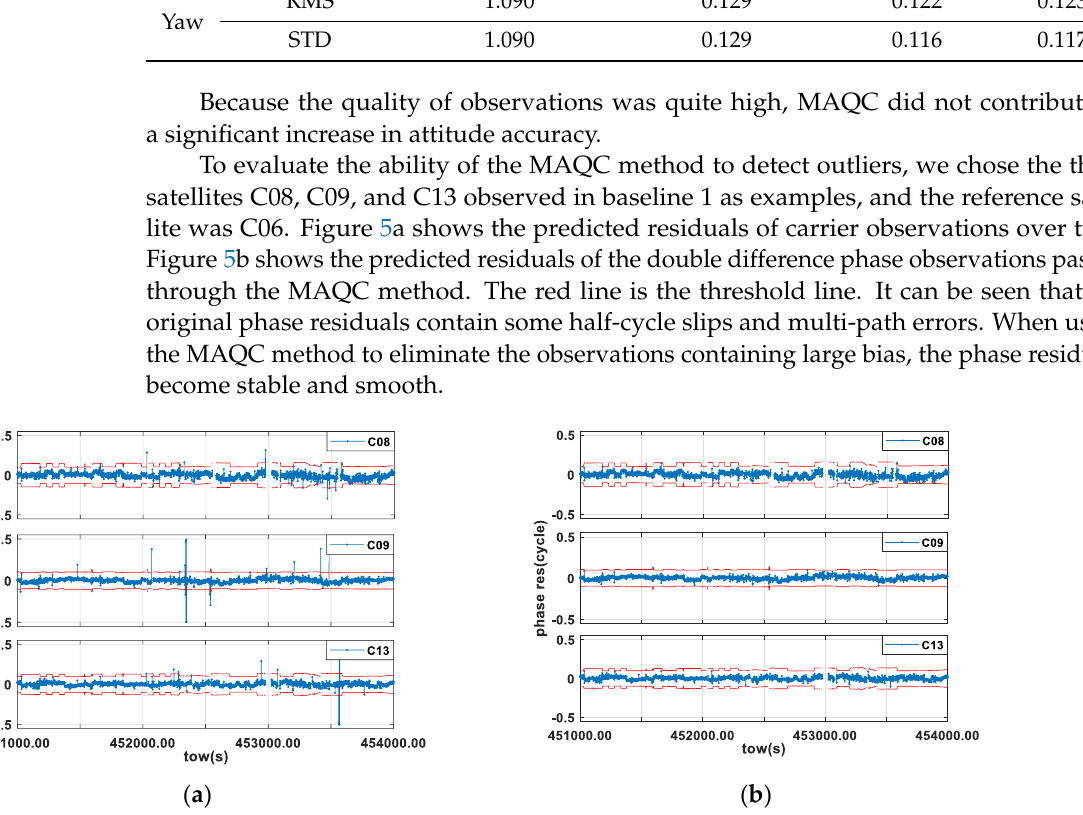
( b ) Figure 6. Residuals of carrier phase in simulated experiment: ( a ) prediction residuals of carrier phase; ( b ) residuals of the retained carrier phase measurements by MAQC method. The rea lines symbolize the threshold value. The blue lines sym- bolize the residuals.